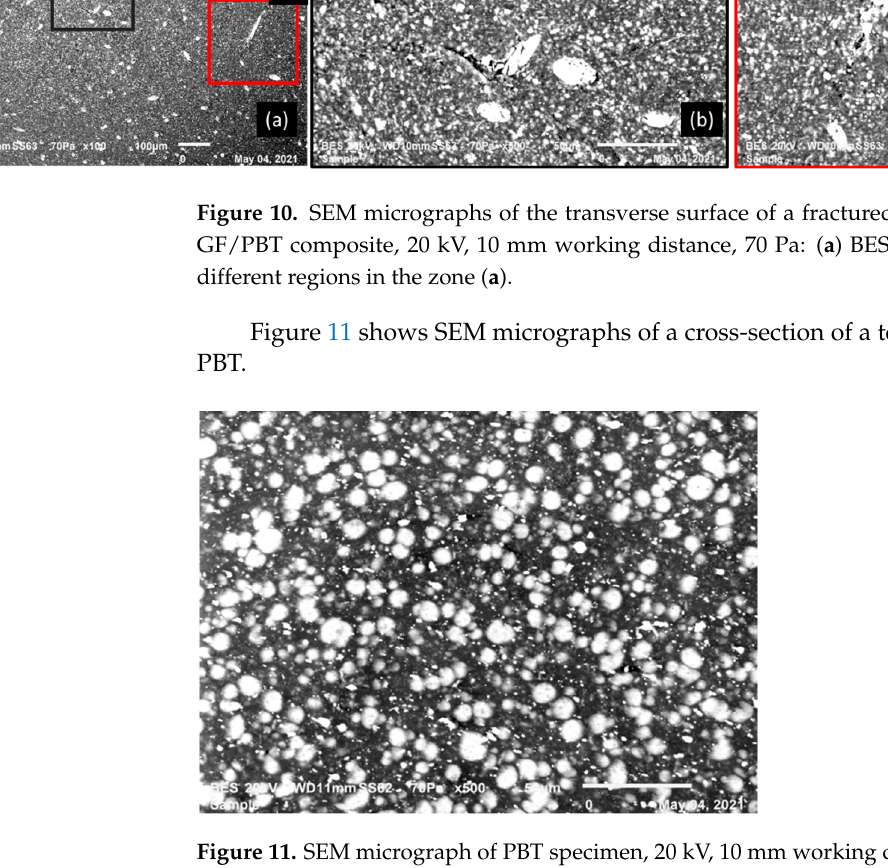
Figure 11. SEM micrograph of PBT specimen, 20 kV, 10 mm working distance, 70 Pa.